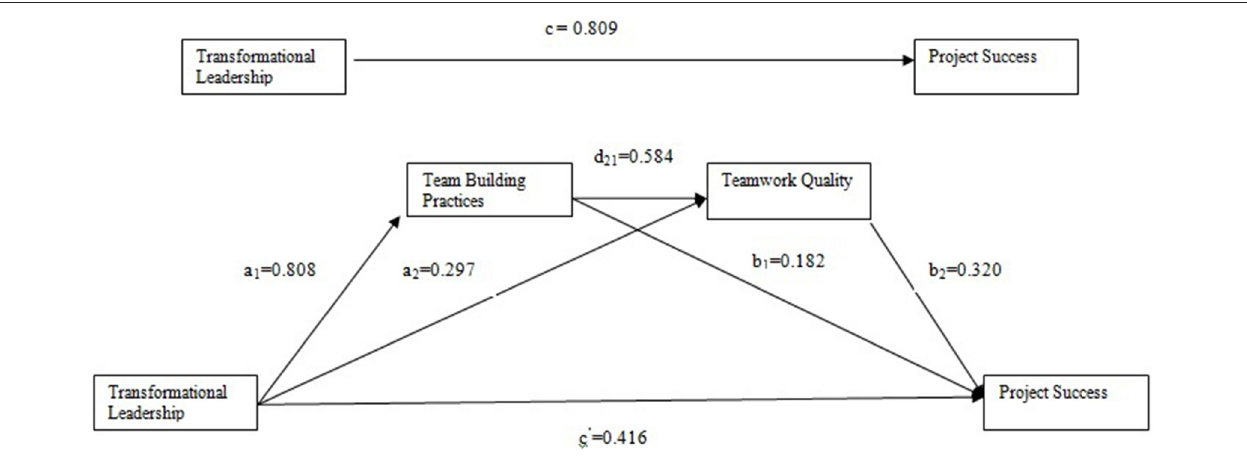
FIGURE 2 | Mediation model. Notes: N = 374, *p < 0.05, **p < 0.01, ***p <